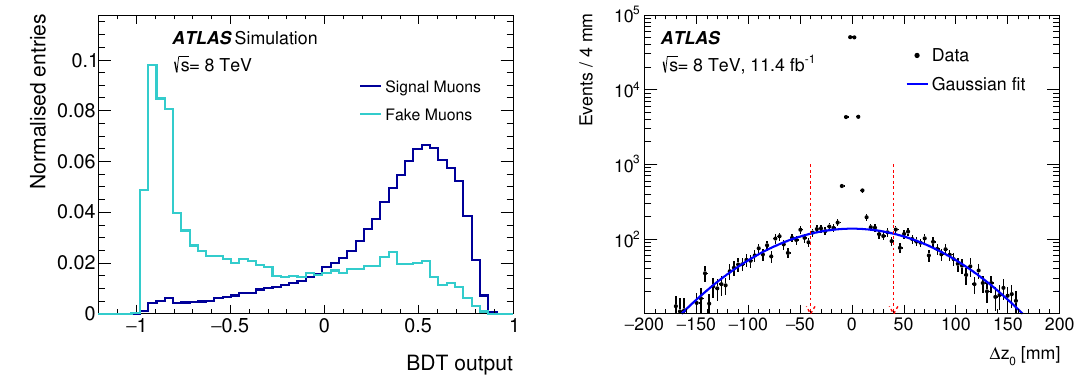
Figure 2 . Left: distribution of the BDT output for signal muons (dark blue) and background fake muons (light blue) taken from simulation. Right: data (cid:1) z 0 distribution for the inclusive data set including the Gaussian pile-up background (cid:12)t. The Gaussian function is (cid:12)tted using the data outside the region marked by the dashed